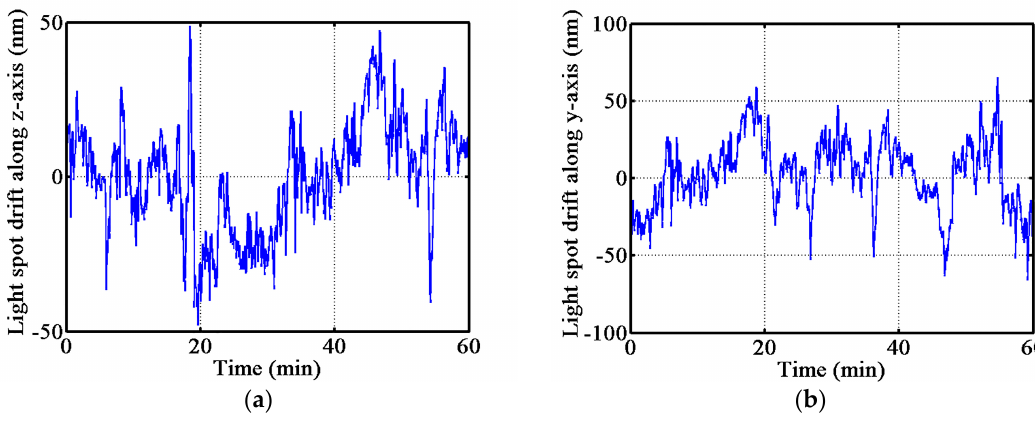
Figure 10. Stability experiment result of the probe system. ( a ) The drift of light spot along the z-axis, and ( b ) the drift of the light spot along the y-axis.